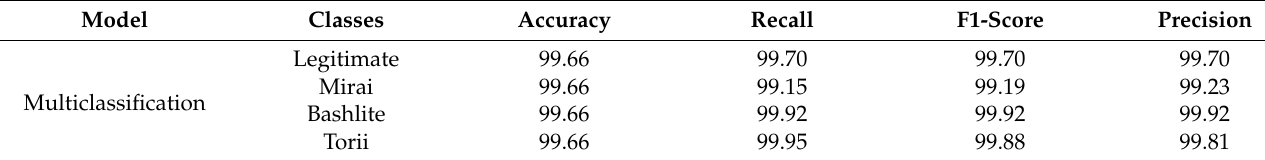
Table 11. Measurement results for 4